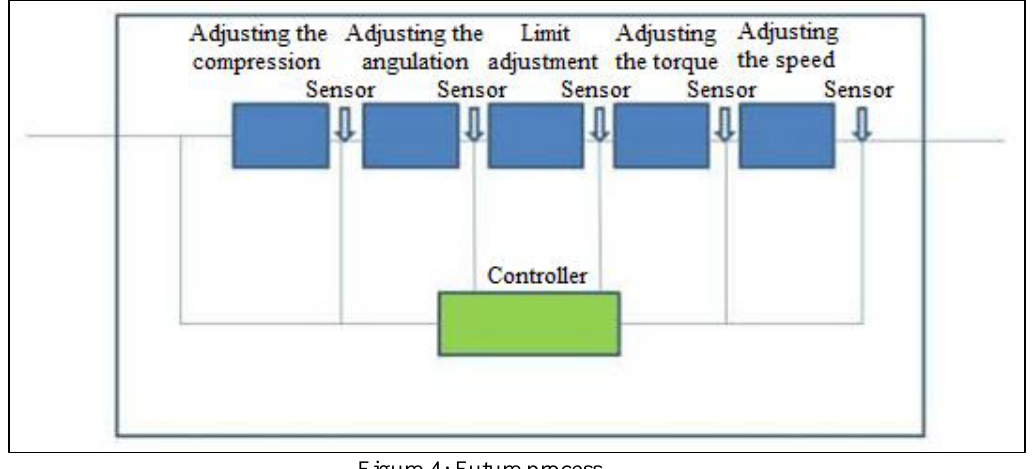
Figure 4: Future